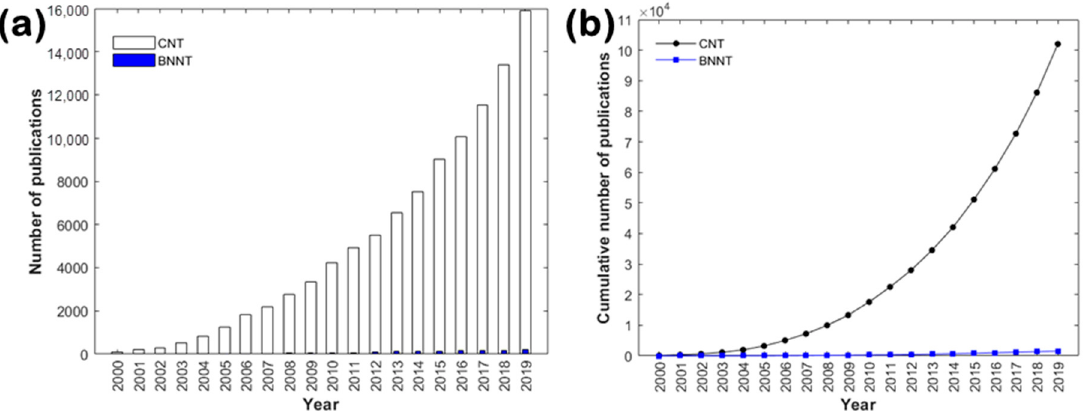
Figure 1. Search results in Scopus (September 2020) for ( a ) the annual number of peer-reviewed publications on BNNTs and CNTs (the solid bars for BNNTs can be barely noticed) and ( b ) the cumulative number of peer-reviewed publications between the years 2000 and 2019.